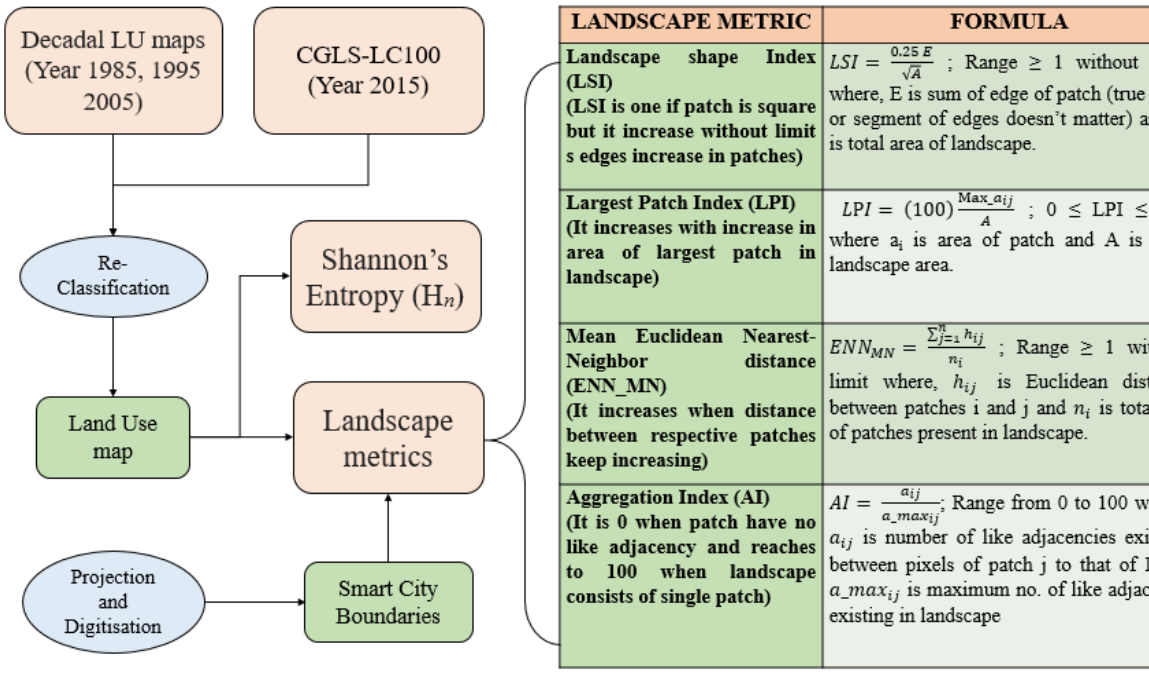
Figure 2 . Flow chart showing methodology used in